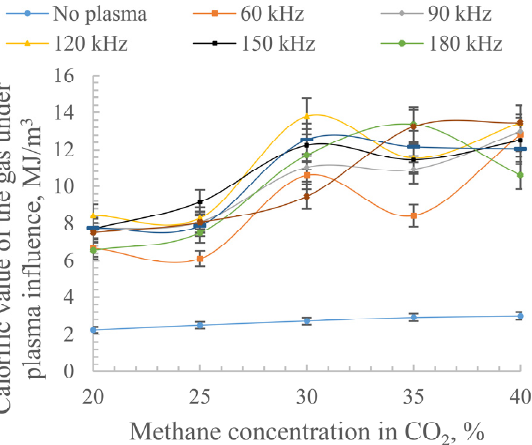
Figure 10. Graphs of the calorific value in dependence of the frequency and mixture variant.